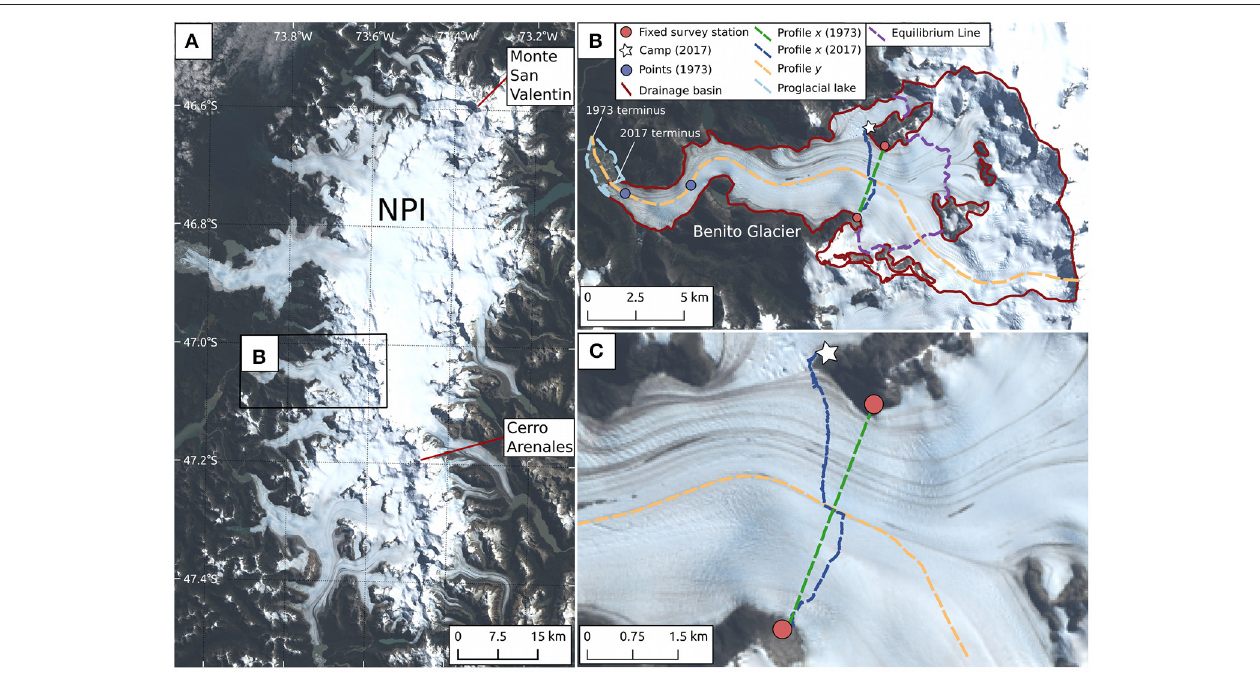
FIGURE 1 | (A) True color Landsat 8 image of the Northern Patagonian Icefield on 12 March 2015. (B) Benito Glacier with location of the camp site, elevational profiles and fixed survey stations used in this study. The drainage basin was derived from the Global Land Ice Measurements from Space (GLIMS) database (Raup et al., 2007 ). (C) Zoomed location map showing location of the 1973 and 2017 elevation profiles and camp